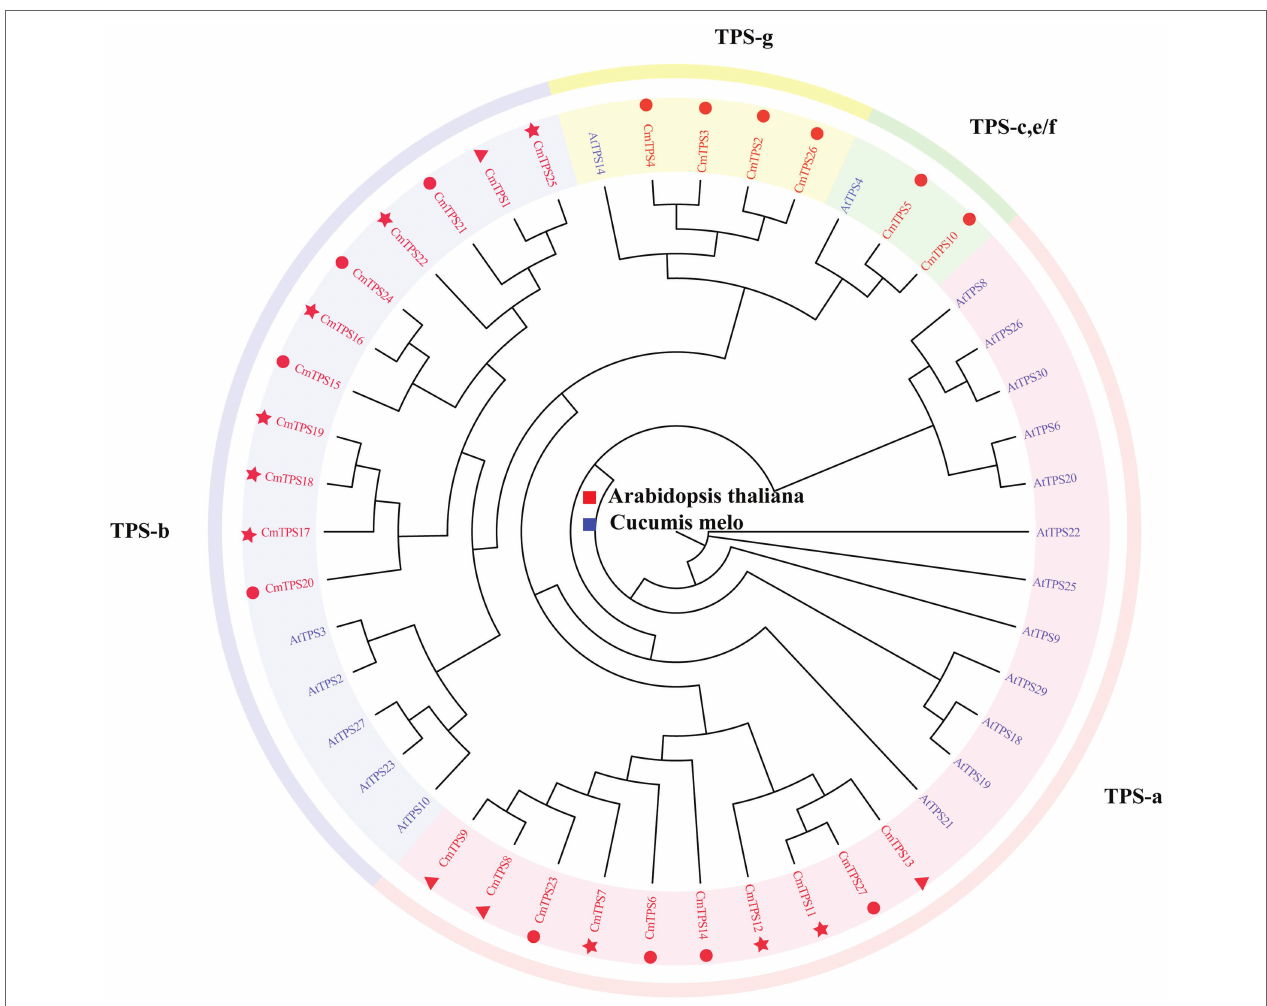
FIGURE 6 | Phylogenetic tree of TPSs from melon and Arabidopsis . CmTPSs are colored red. AtTPSs are colored blue. The triangle, round, and star in front of the CmTPSs , respectively, represent softcore, core, and shell genes. The phylogenetic tree was constructed using the neighbor-joining (NJ) method and the Jones– Taylor–Thornton (JTT) model with 1,000 bootstrap replicates in FastTree